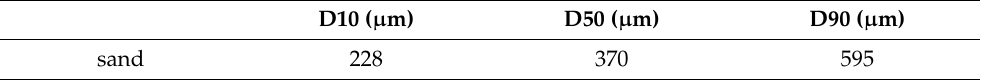
Figure 4. Cumulative PSD curves for sand used as fine aggregates.